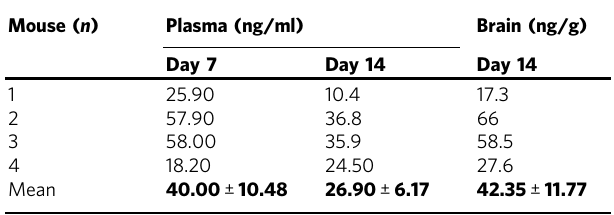
Table 4 Felodipine plasma and brain concentration in mice during and after 14 day dosing via minipump